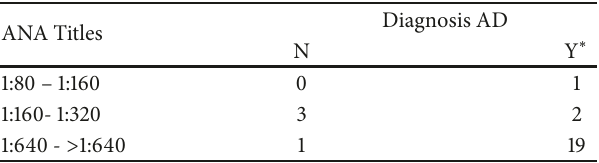
Table 2: Titers of ANA tests and clinical diagnosis of autoimmune diseases in anti-ENA-negative